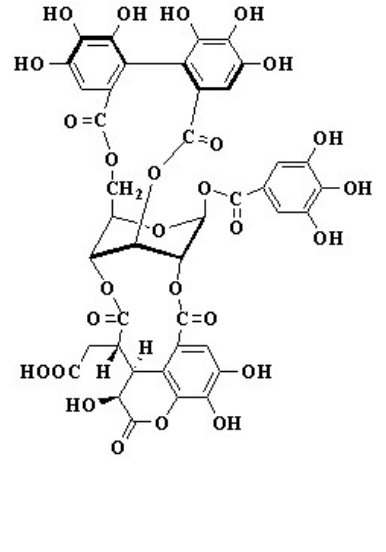
Figure 1. The structure of chebulagic